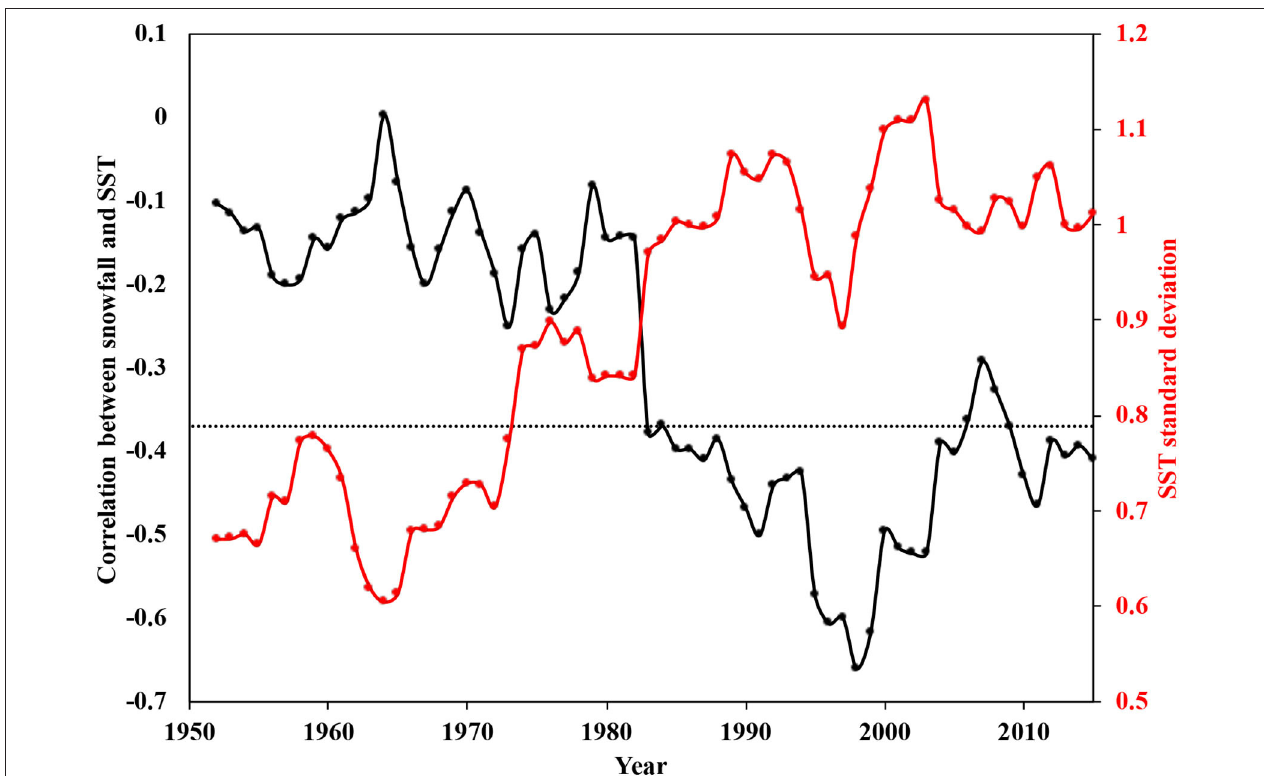
FIGURE 6 | Temporal variation in the 21-year sliding correlation between SST34 and the average annual snowfall over the eight stations (the solid black line). For example, the correlation at 1983 is calculated using SST34 and snowfall over the period of 1963–1983. The dashed straight line indicates correlation significance at the 95% confidence level. Also shown in this figure is the standard deviation of the corresponding 21 years of SST34 (the red solid line).